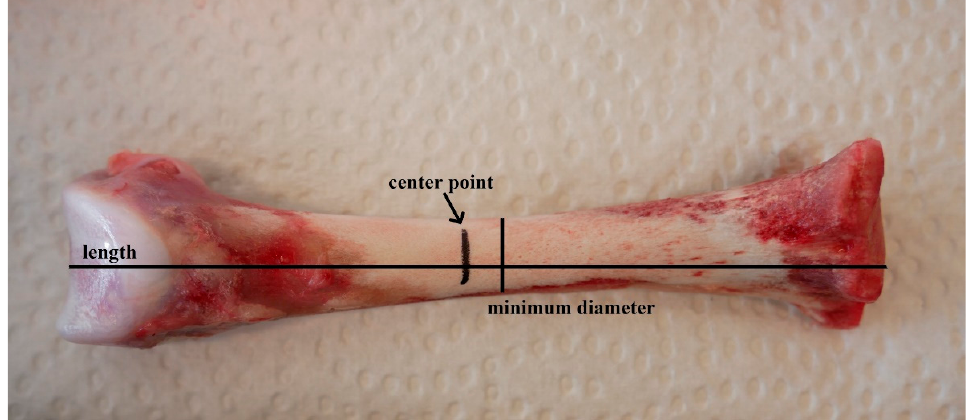
Figure 1. Prepared tibiotarsus for measuring of minimum diameter and length, with marked centre- point for three-point bending test.